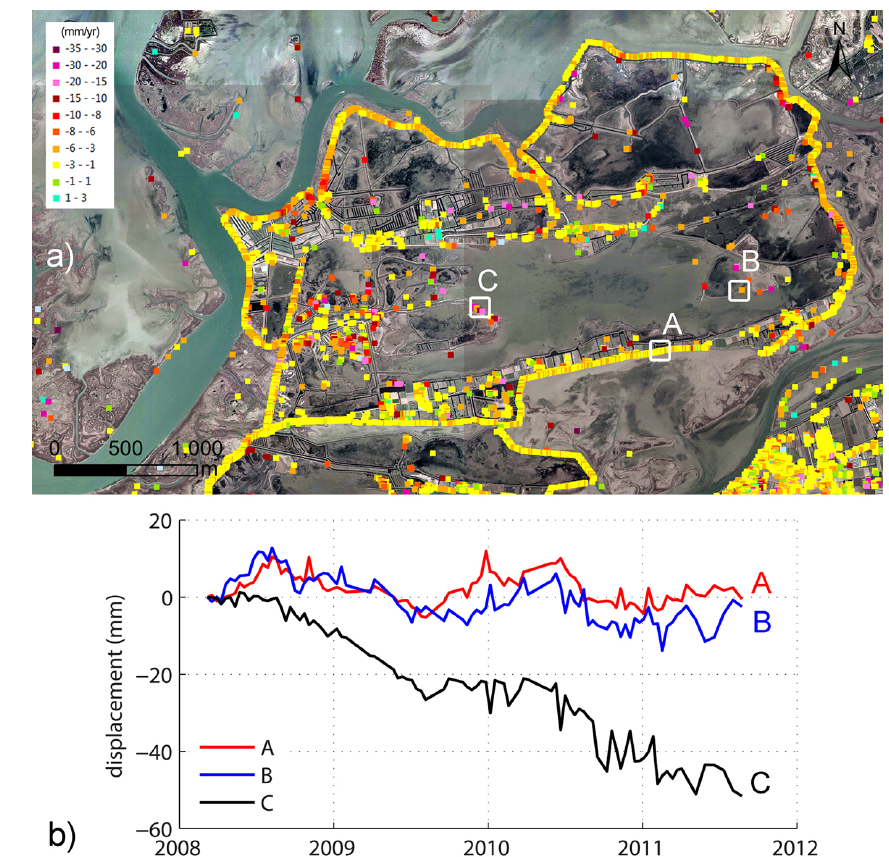
Figure 4. (a) Mean displacement rates between March 2008 and August 2011 from TerraSAR-X interferometry at Valle Paleazza, Northern Venice lagoon. The image background is an aerophotograph acquired in 2007. Negative values indicate settlement, positive mean uplift. (b) Displacement history in the satellite line-of-sight direction for three scatterers (A, B, C). See location 2a in Fig.